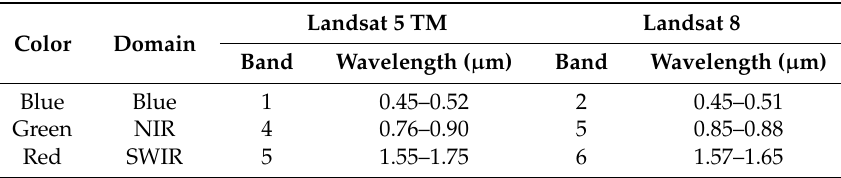
Table 6. Landsat band combination used for the